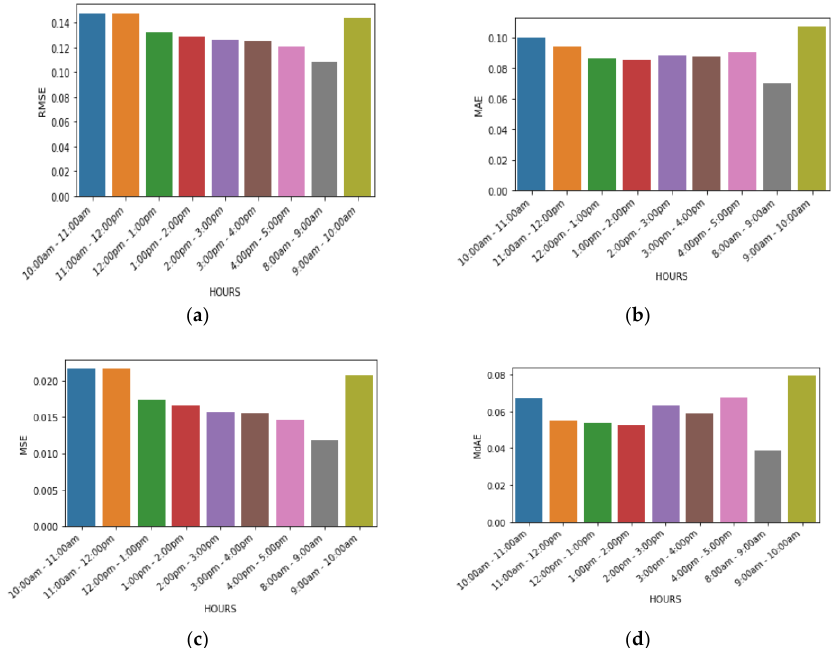
Figure 9. Parking availability prediction error rate with respect to hour-wise using loss functions: ( a ) RMSE, ( b ) MAE, ( c ) MSE, ( d ) MdSE.